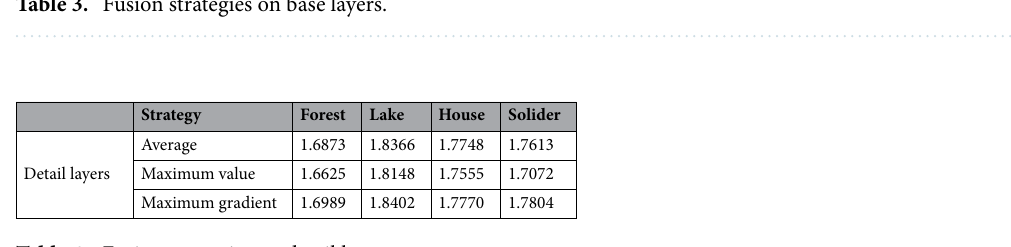
Table 3. Fusion strategies on base layers.